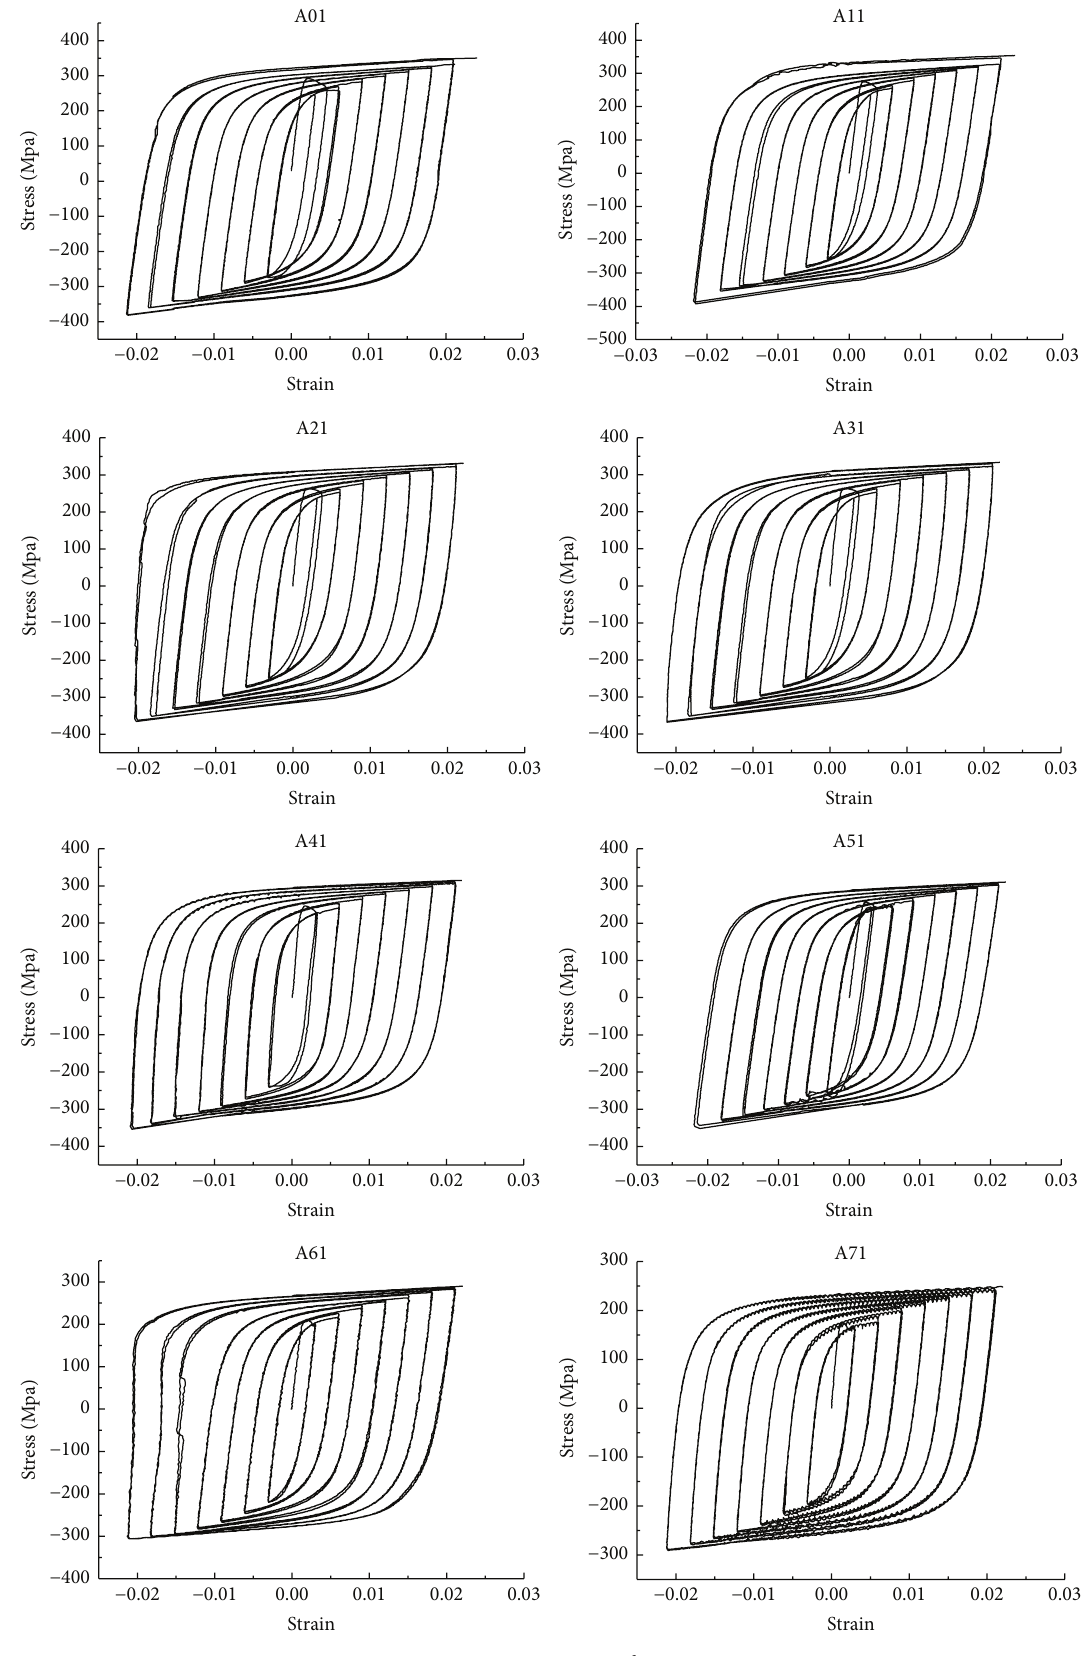
Figure 2: Hysteretic curve of